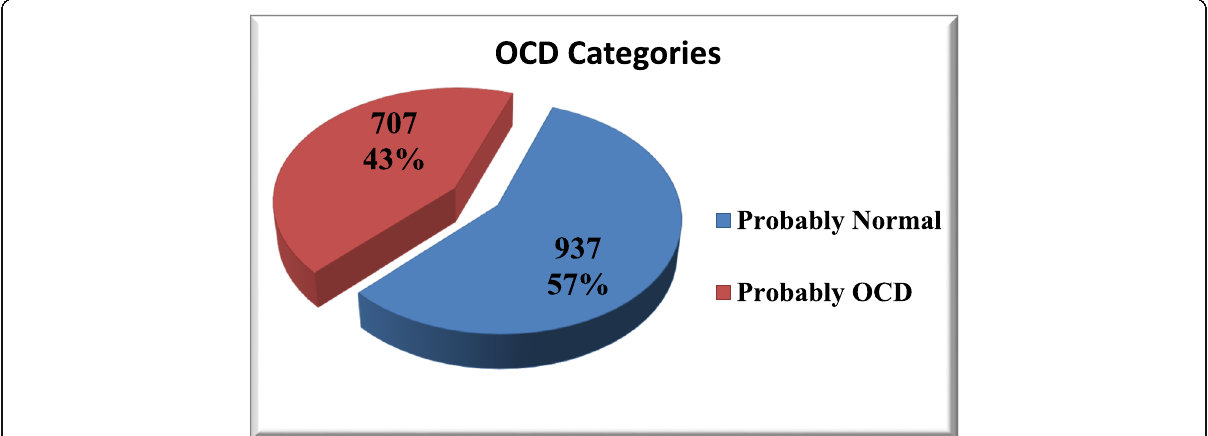
Fig. 1 Frequency distribution of OCD categories among participant